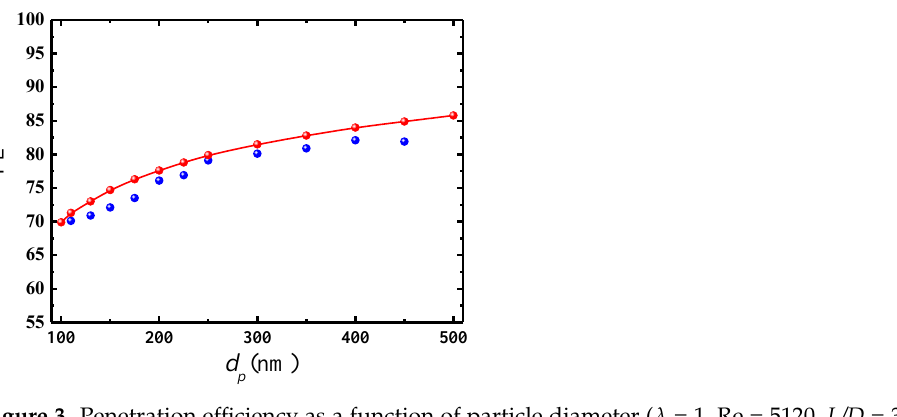
Figure 3. Penetration efficiency as a function of particle diameter ( λ = 1, Re = 5120, L/D = 375). ●: numerical results and • : experimental results [25].